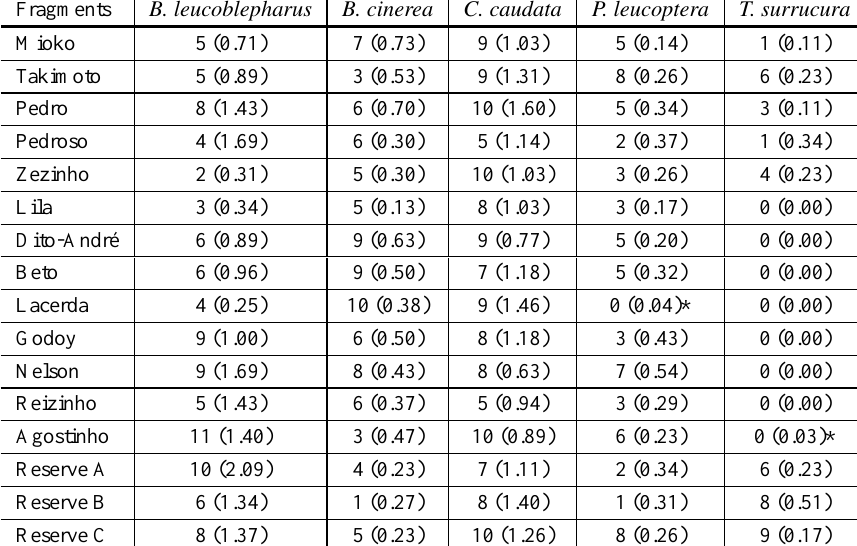
Number of positive responses for each study site obtained after twelve playback sessions per species and abundance values (IPA) in parenthesis (Uezu et al. 2005). Cases where IPA and playback results disagreed are marked with *.